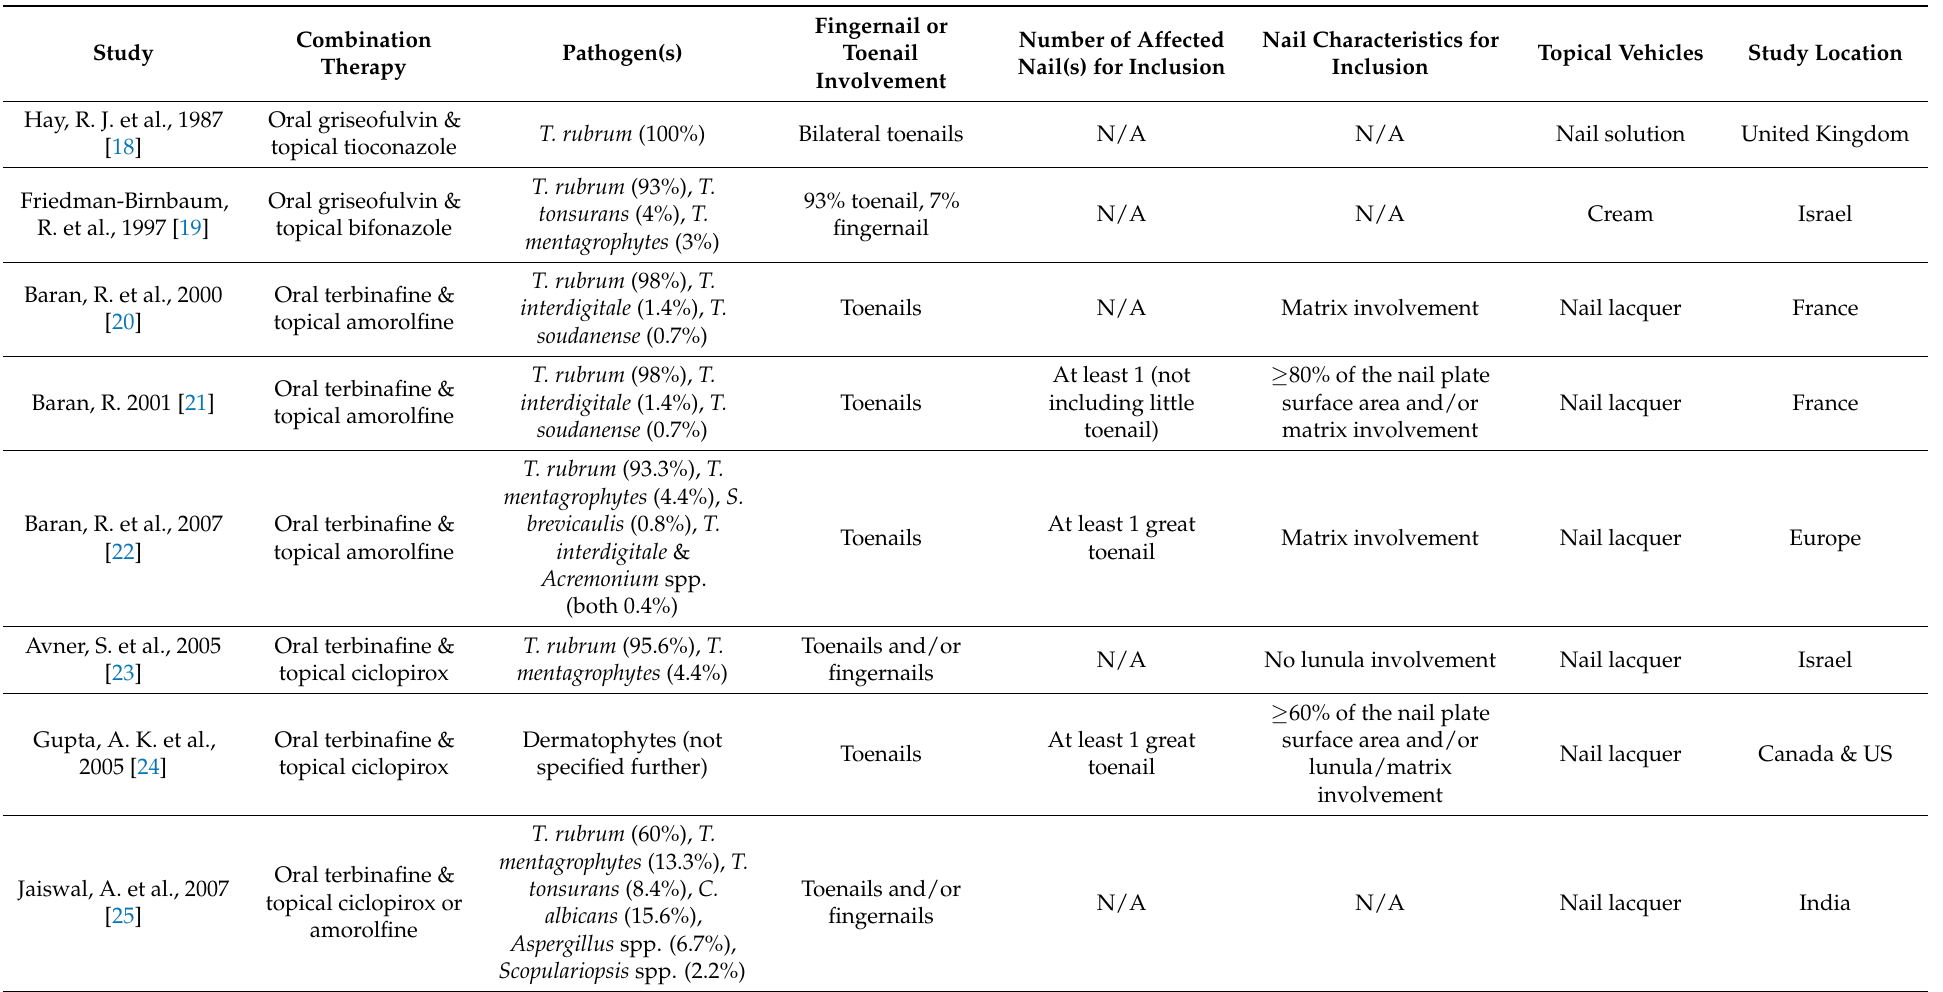
Table 3. Nail characteristics, pathogens, topical vehicles, and study location for all 30